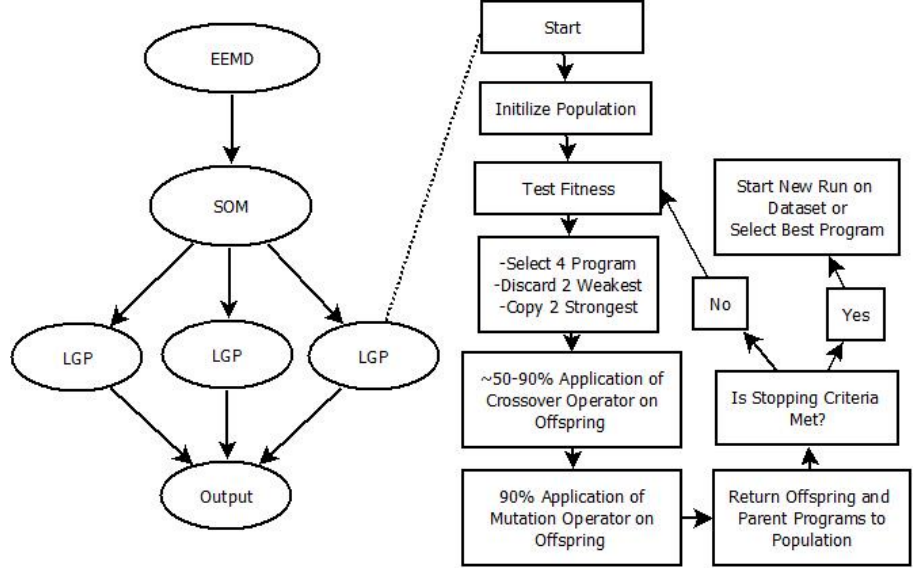
Figure 4. Ensemble Empirical Mode Decomposition-Self-Organizing Map-Linear Genetic Programming structure with tournament selection in LGP.